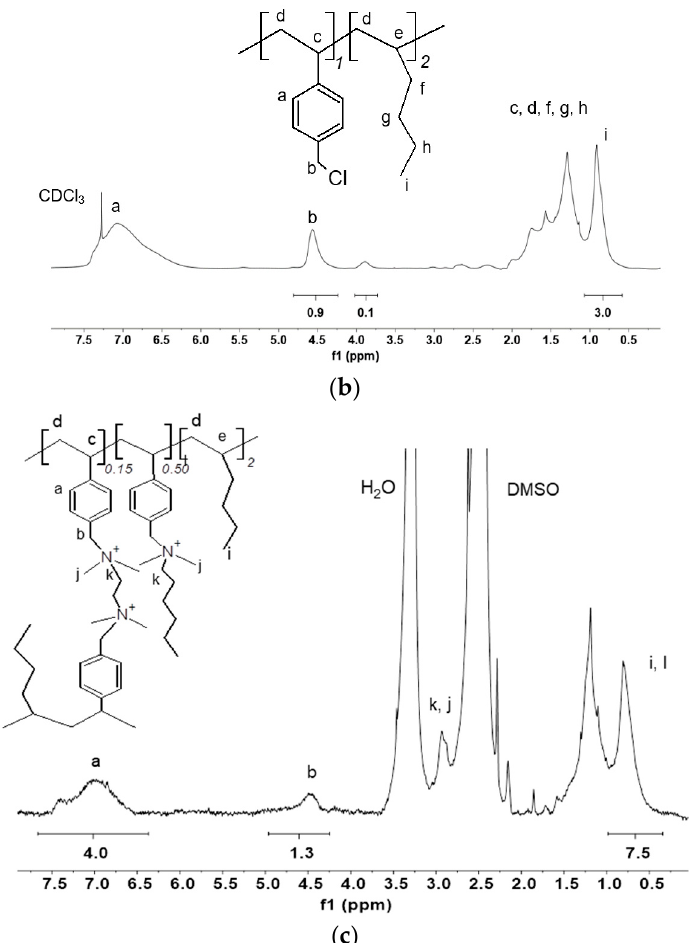
Figure 3. 1 H ‐ NMR spectra of: ( a ) Copolymer poly(VBCl ‐ co ‐ hexene) synthesized with a ratio hex ‐ Figure 3. 1 H-NMR spectra of: ( a ) Copolymer poly(VBCl-co-hexene) synthesized with a ratio hex- ene:VBCl 4:1 in CDCl 3 ; ( b ) Copolymer poly(VBCl ‐ co ‐ hexene) synthesized with a ratio hexene:VBCl ene:VBCl 4:1 in CDCl 3 ; ( b ) Copolymer poly(VBCl-co-hexene) synthesized with a ratio hexene:VBCl 2:1 in CDCl 3 ; ( c ) Aminated and crosslinked ionomer in d 6 ‐ DMSO. 2:1 in CDCl 3 ; ( c ) Aminated and crosslinked ionomer in d 6